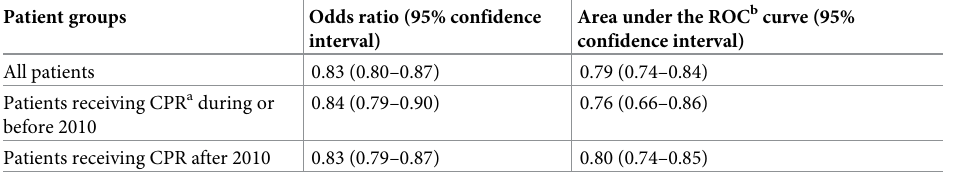
Table 4. Performance of the CASPRI score as a predictive variable for favourable neurological outcome at hospi- tal